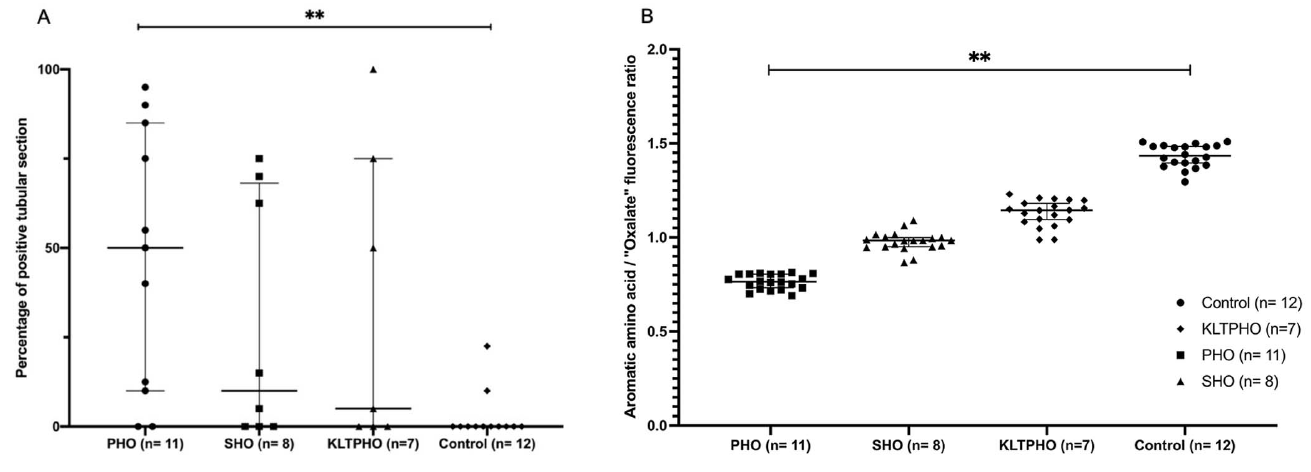
Figure 5 Diffuse intracytoplasmic tubular signal is associated with renal oxalosis. (A) Percentage of positive tubular section. Fluorescence intensity ratio between the ‘oxalate’ and aromatic amino acid channel was measured in 20 positive tubular cell cytoplasm regions for each biopsy. (B) Median with 25–75 interquartile range. ** p <